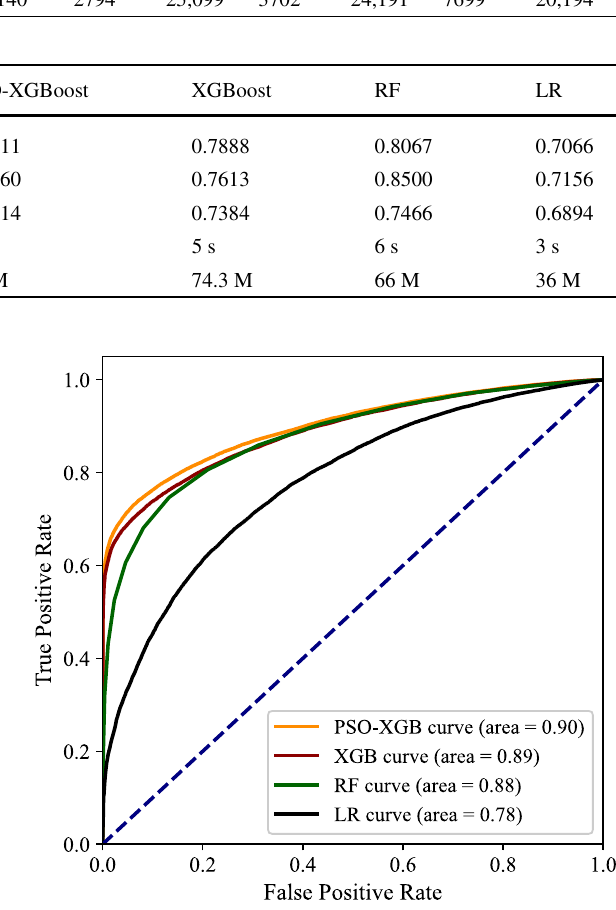
Fig. 7 ROC curves of compared